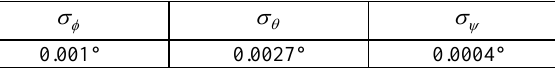
Table 8: Standard deviations of the boresight angles estimated with the simulated data